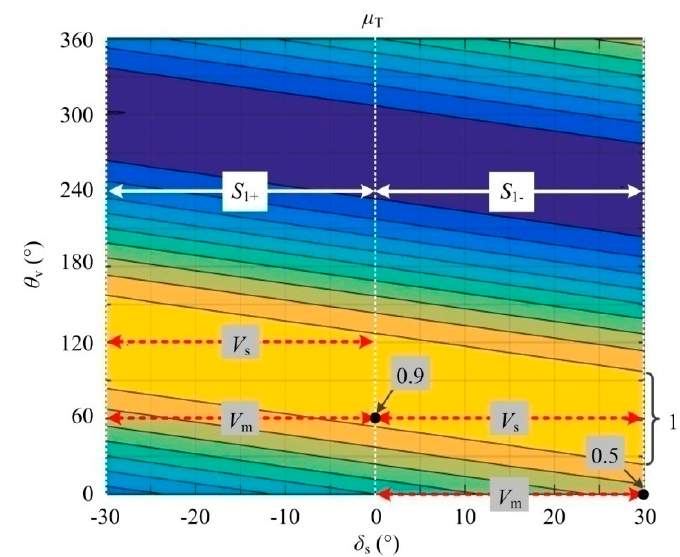
Figure 5. Two-dimensional contour map of torque error active factors.